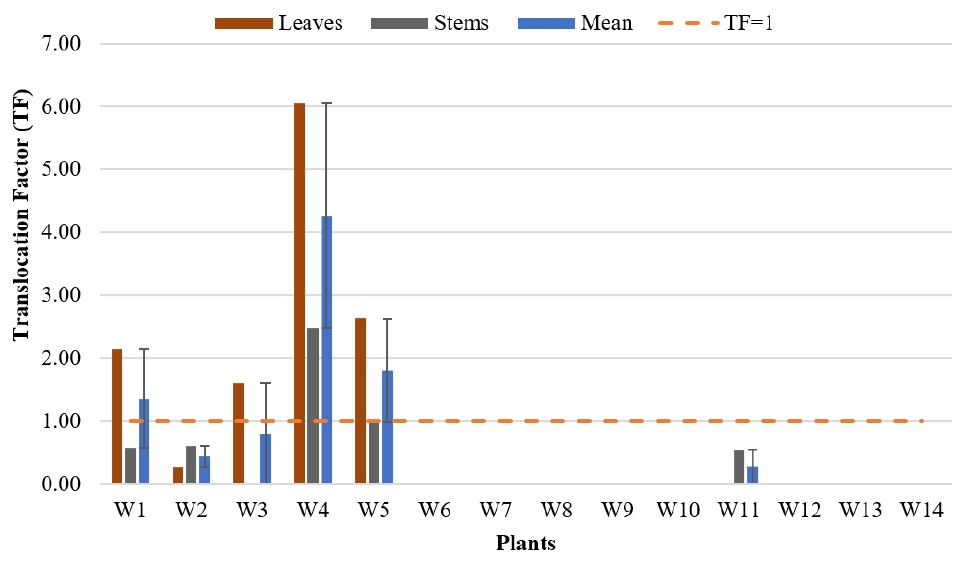
Figure 9. Translocation factor (TF) of magnesium (Mg) in the phytoremediation of domestic sewage mesocosms using various tropical plants.